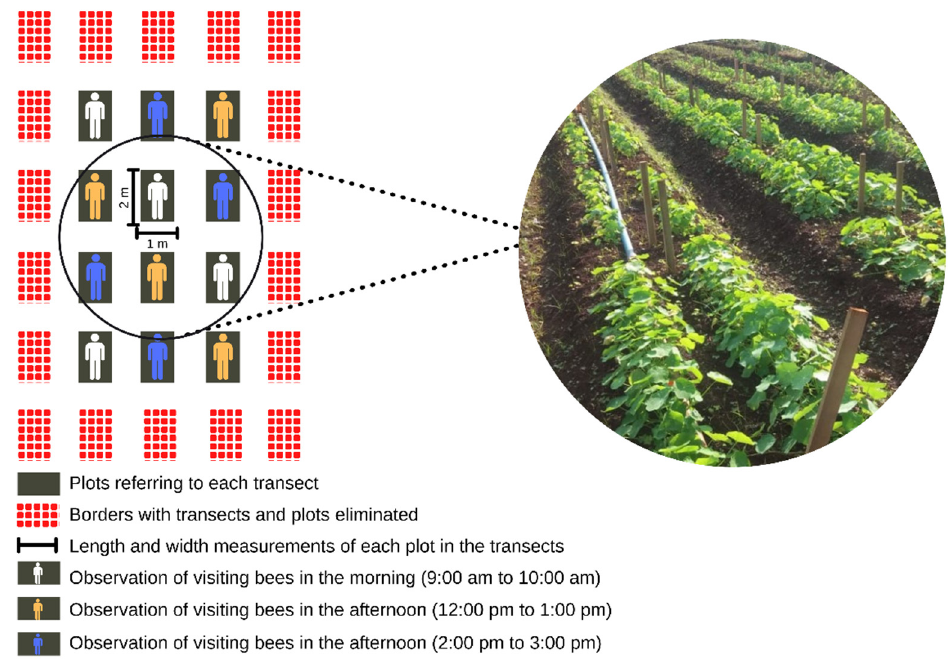
Figure 1. Experimental design of the sampling site containing the transects and plots with plants and flowers of T. majus and the hours of observation of the visiting bees.